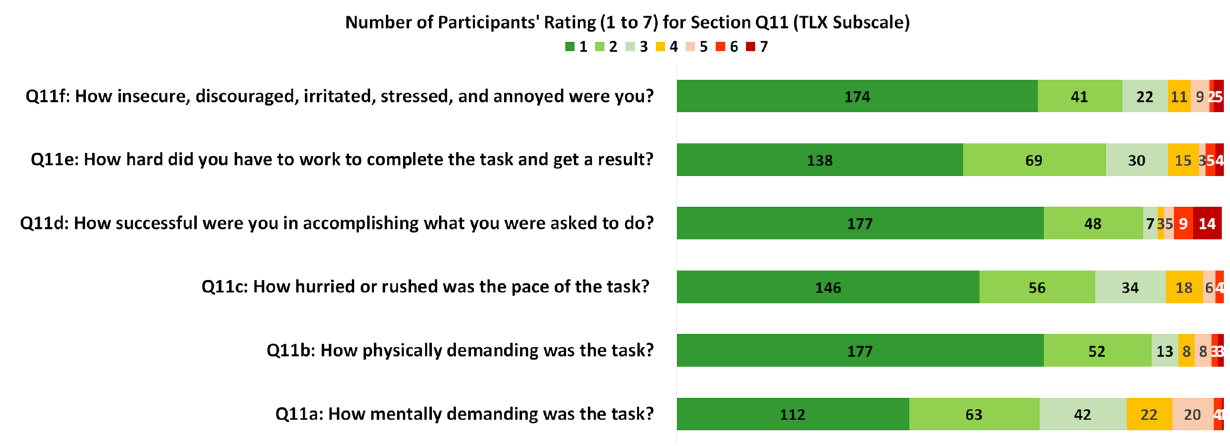
Figure 8. Summary of number of participants’ rating in six TLX